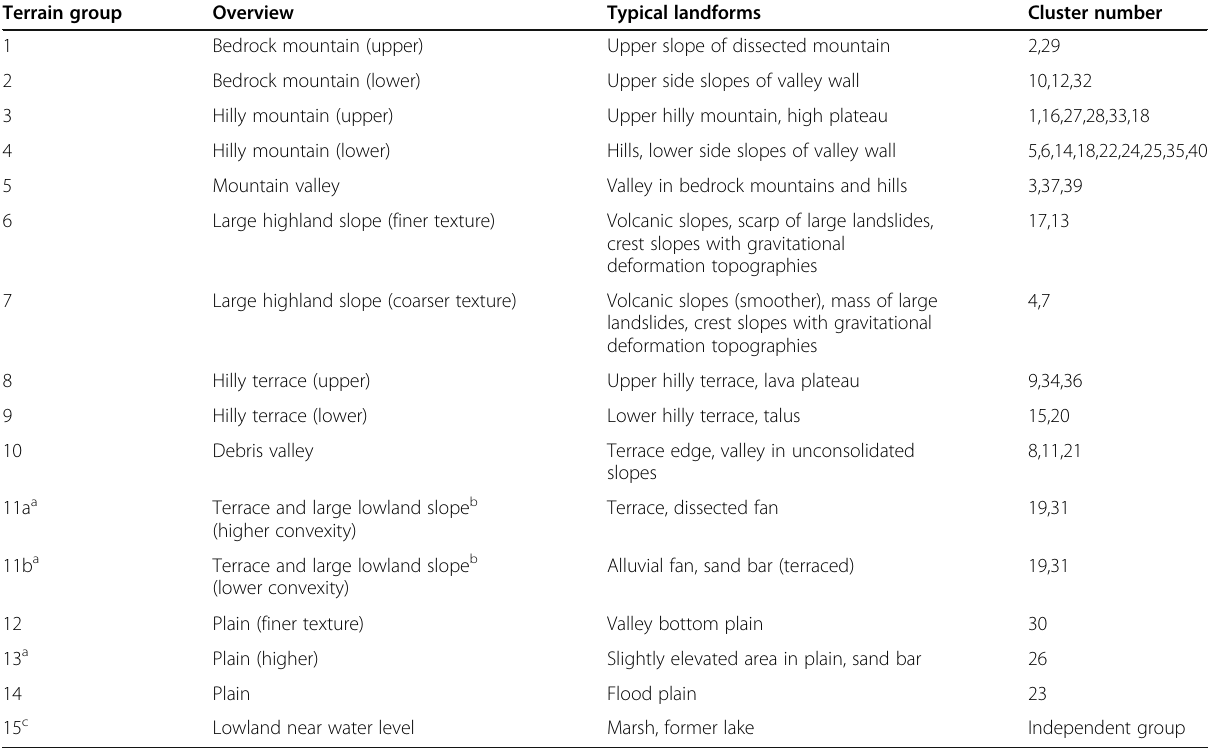
Table 3 Descriptions of final terrain groups (Group_fin in Fig. 7) Terrain